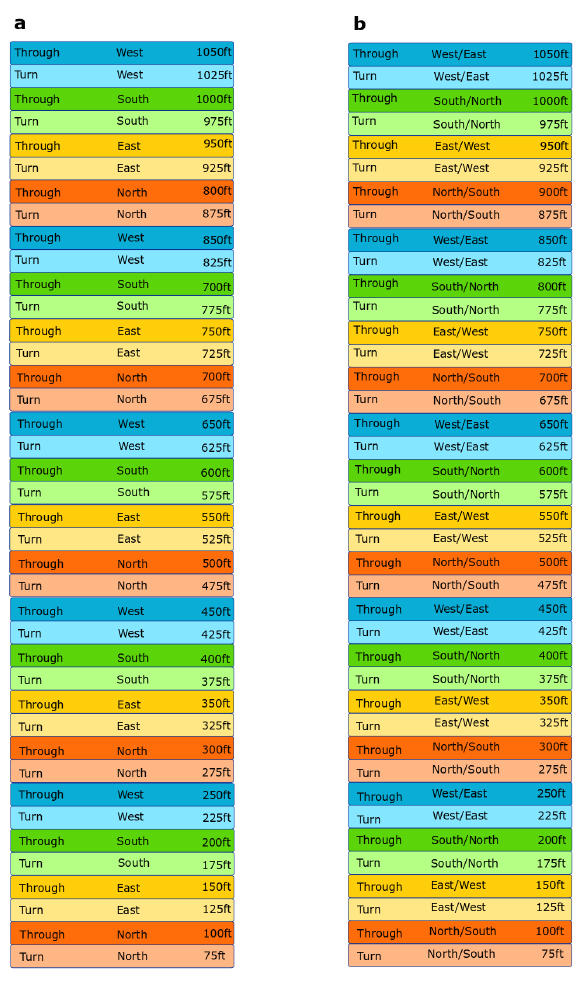
Figure 3. Schematic view for the complete set of altitude bands for the two urban airspace designs, where each altitude layer corresponds to its respective travel direction. Each concept has 40 altitude layers (which consist of 20 altitude layers allocated for through traffic and 20 altitude layers for turn traffic) from 75 to 1050 ft with a vertical spacing of 25 ft, respectively. The turn-layers are used for transitory flights, that is, drones that need to make turns/change direction at intersections. While the through-layers are utilised by through traffic, that is traffic passing through at least one